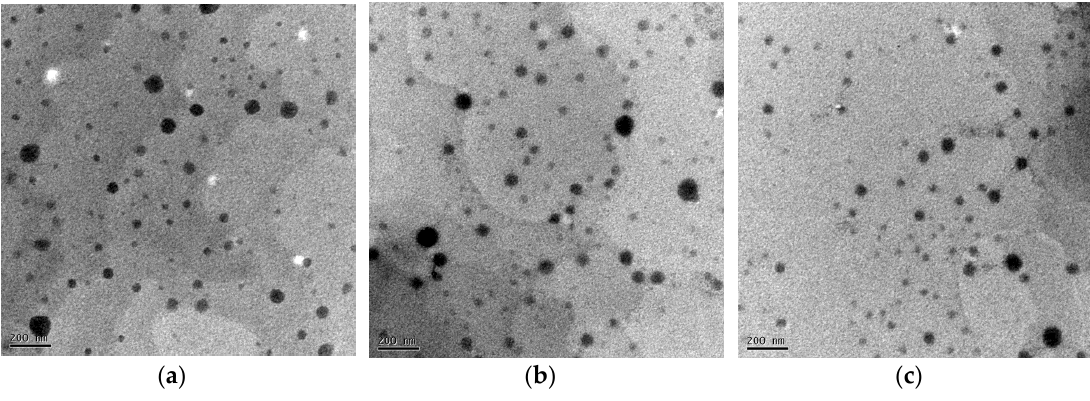
Figure 1. Transmission electron microscopy (TEM) photographs of the Diosarg-DOPE aggregates: ( a ) Diosarg-DOPE (2:1) nanoparticles (NPs); ( b ) Diosarg-DOPE (1:1) NPs; ( c ) Diosarg-DOPE (1:2) NPs; scale bar: 200 nm.